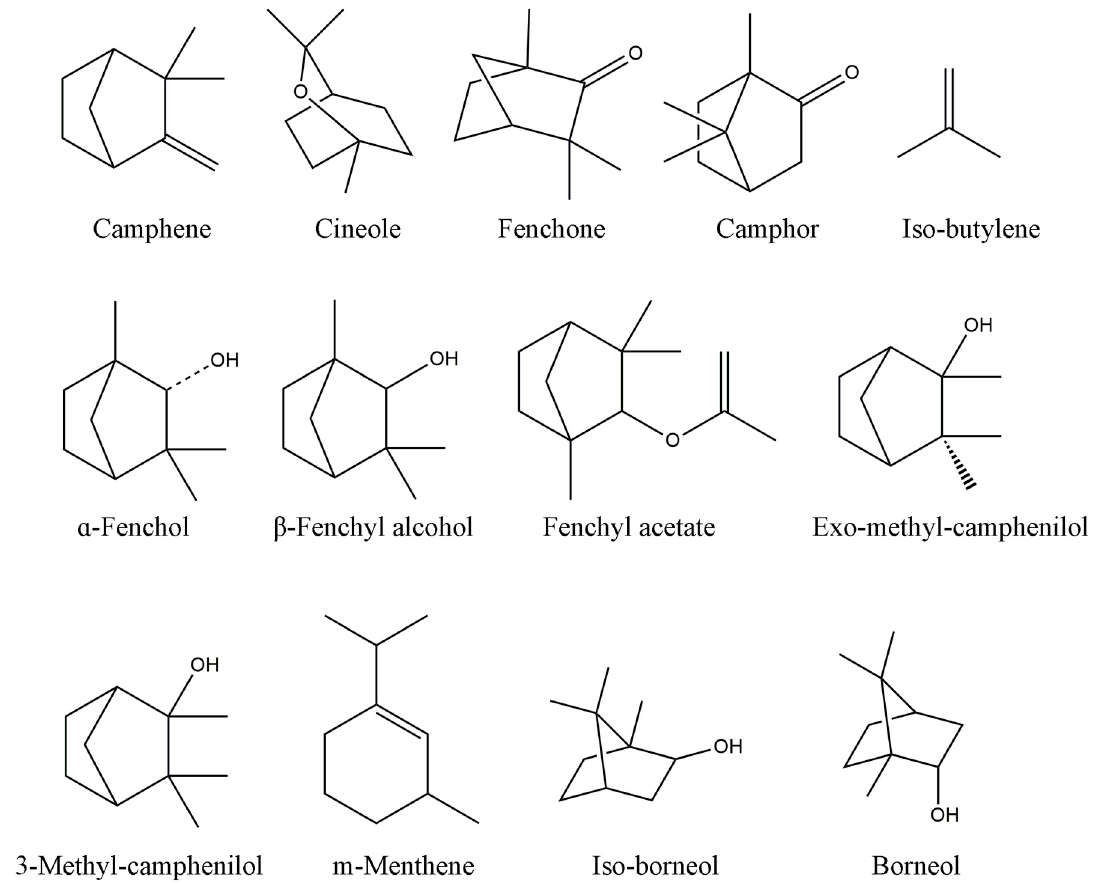
Figure 2. The chemical structure of compounds in NB and SB by GC-MS analysis.